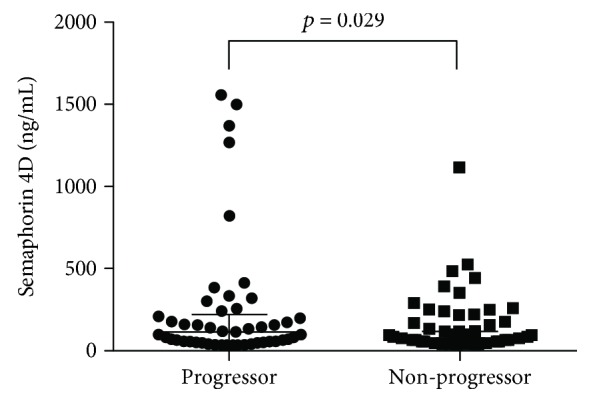
The relations of serum Sema4D levels with radiographic progression.